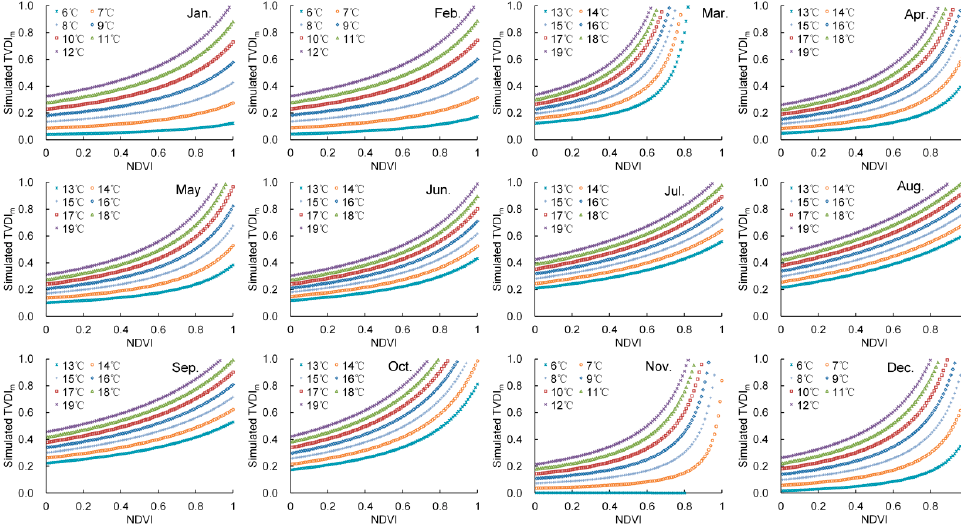
Figure 8. The simulated TVDI m based on the improved dry/wet edges in 2005.